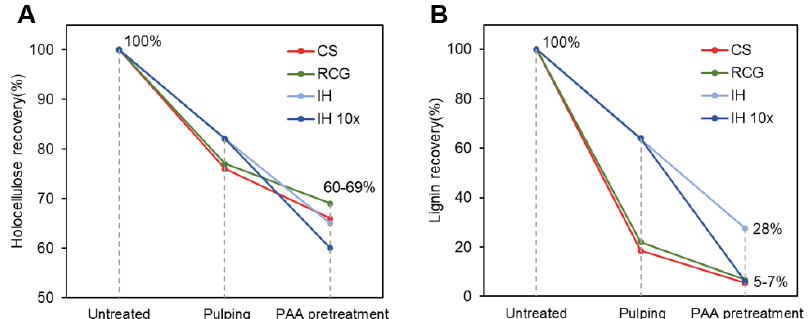
Figure 2. Recovery percentages of ( A ) holocellulose and ( B ) lignin components after pulping and PAA pretreatment related to untreated biomass. The complete recovery results are shown in Supporting Information, Table S2.